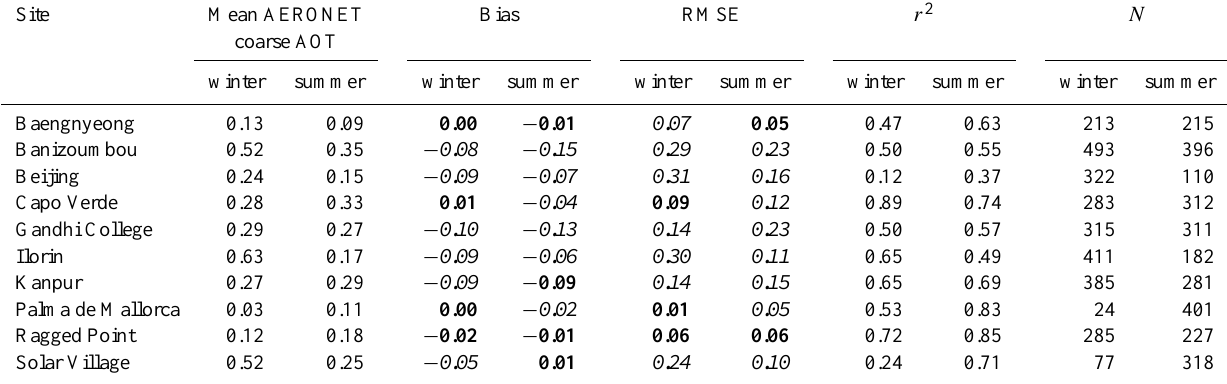
Table 4. Same as Table 2, except for coarse-mode AOT at 550nm and for sites in which the coarse mode is dominated by dust. Site Mean AERONET Bias RMSE